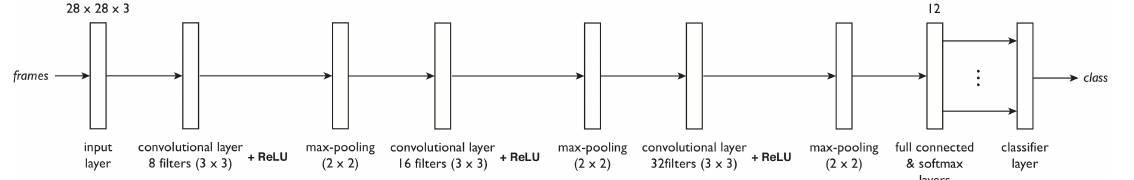
Figure 17. CNN topology using raw video